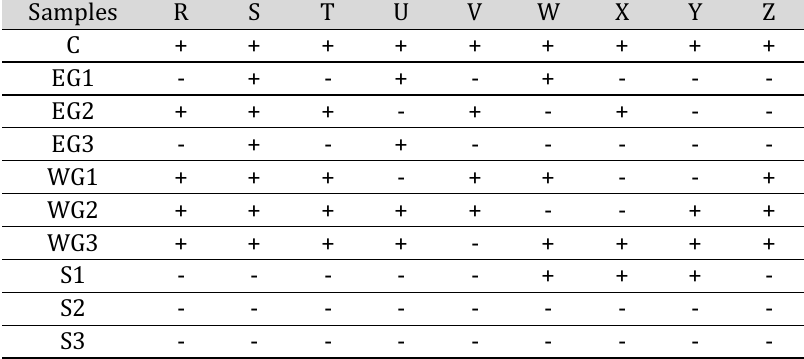
Table 9. Microbial isolates of treated palm oil and their occurrence at each day of the